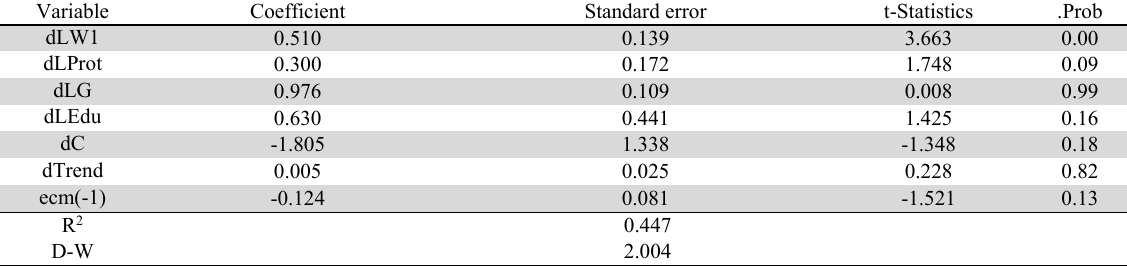
The Error Correction Mechanism with time trend Variable